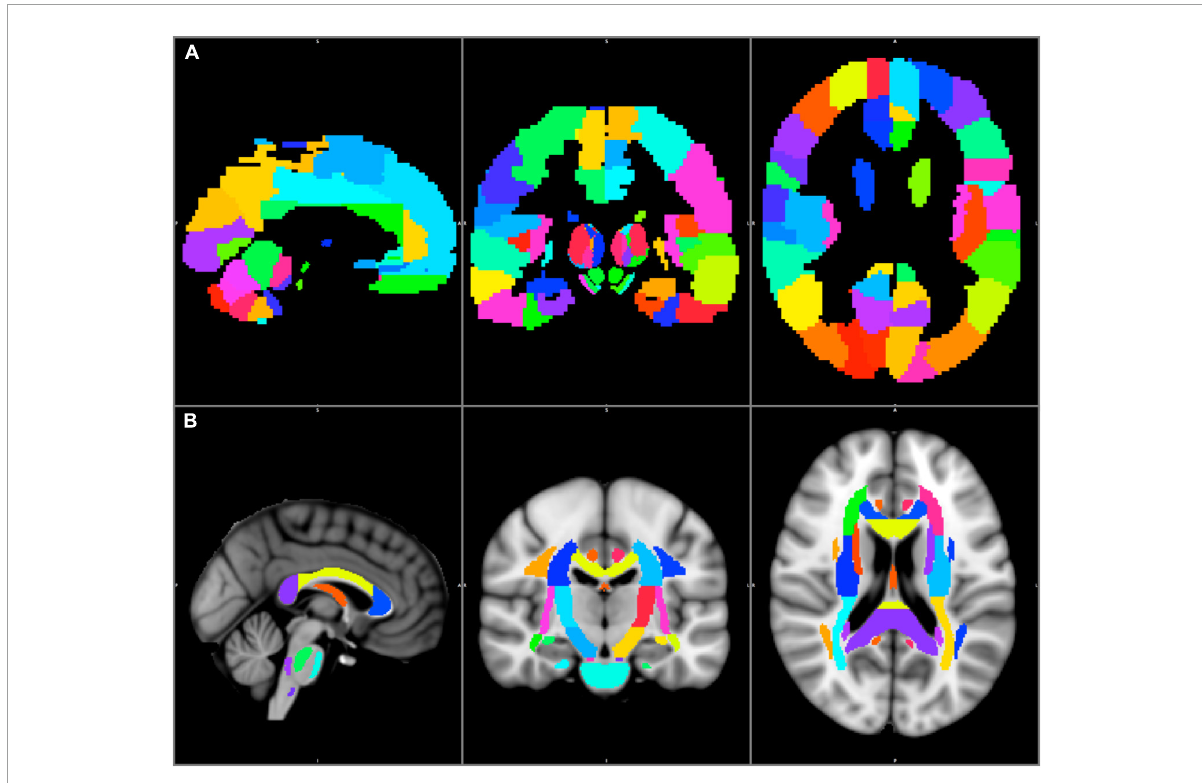
FIGURE1 The AAL3 cortical (A) and the JHU–ICBM–DTI–81 white matter labels subcortical (B) regions are shown in the MNI152 1 mm